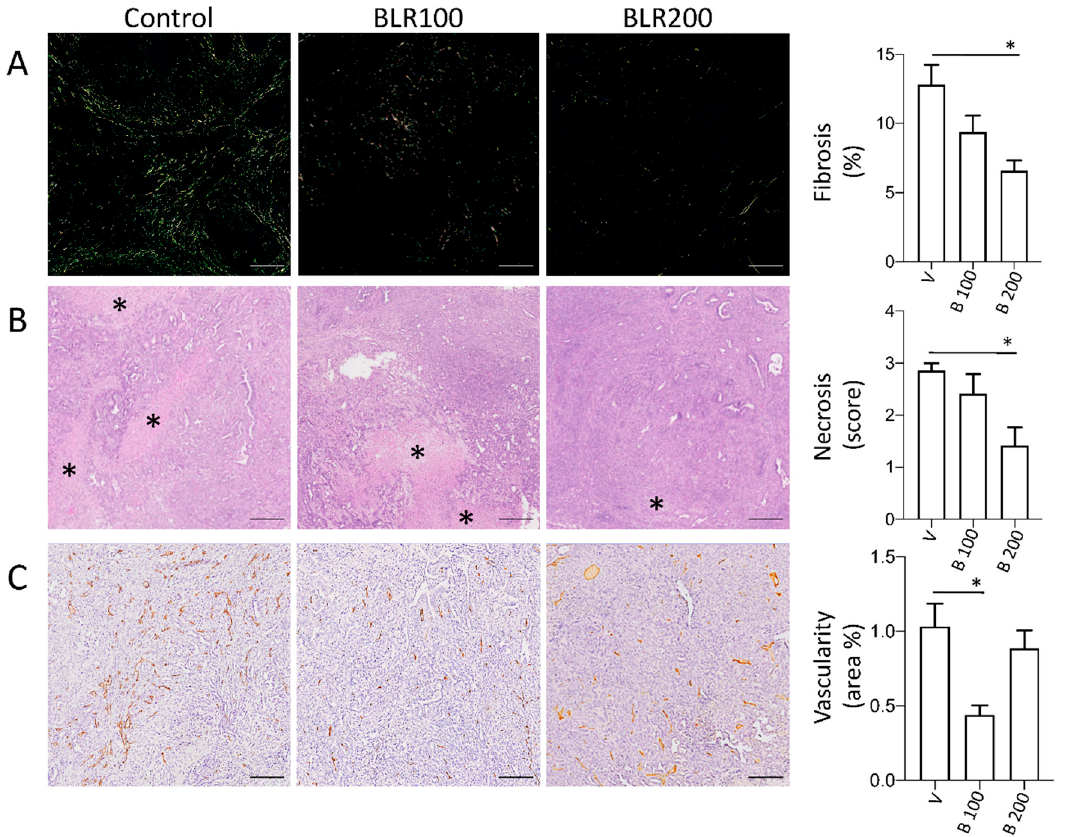
Figure 3. Microenvironmental changes induced by BLR100 or BLR200 on PDAC tumors. Representative images and relative quantification of ( A ) fibrosis (polarized light microscopy analysis of Sirius red stained sections; scale bars, 25 µ m), ( B ) necrosis (asterisks, H&E staining; scale bars, 200 µ m) and ( C ) tumor vessels (CD31 IHC; scale bars, 200 µ m) of control and peptide-treated FC1199 orthotopic tumors. N ≥ 6. One way ANOVA and Dunnett’s: * p < 0.05.